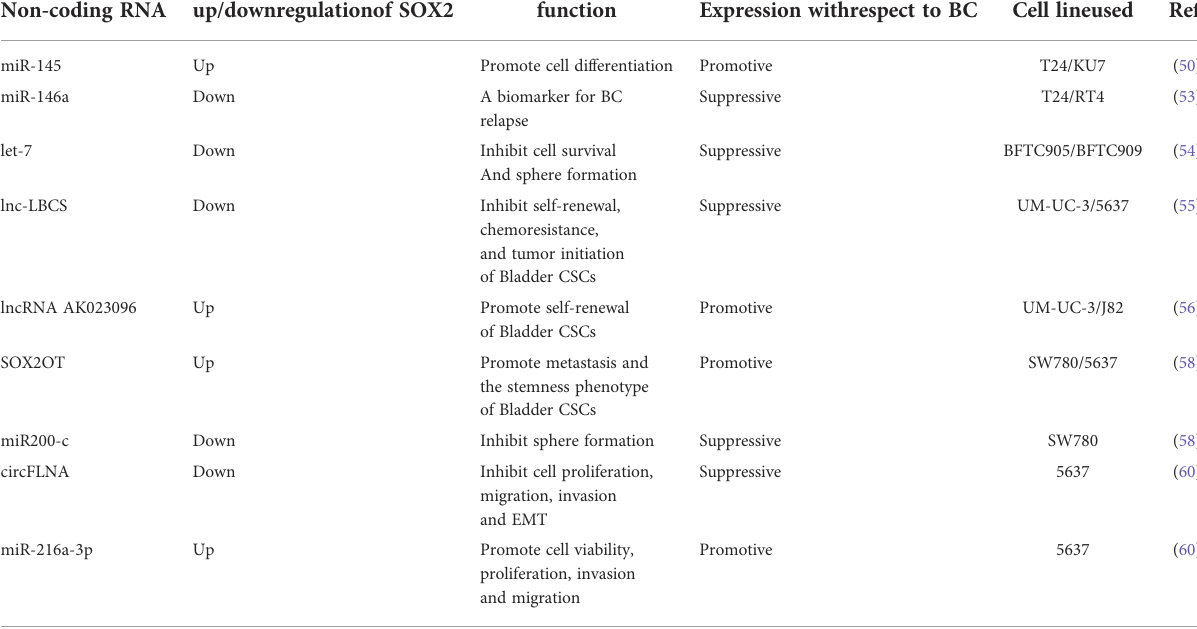
TABLE 1 Summary of non-coding RNAs regulating SOX2 expression in bladder cancer. Non-coding